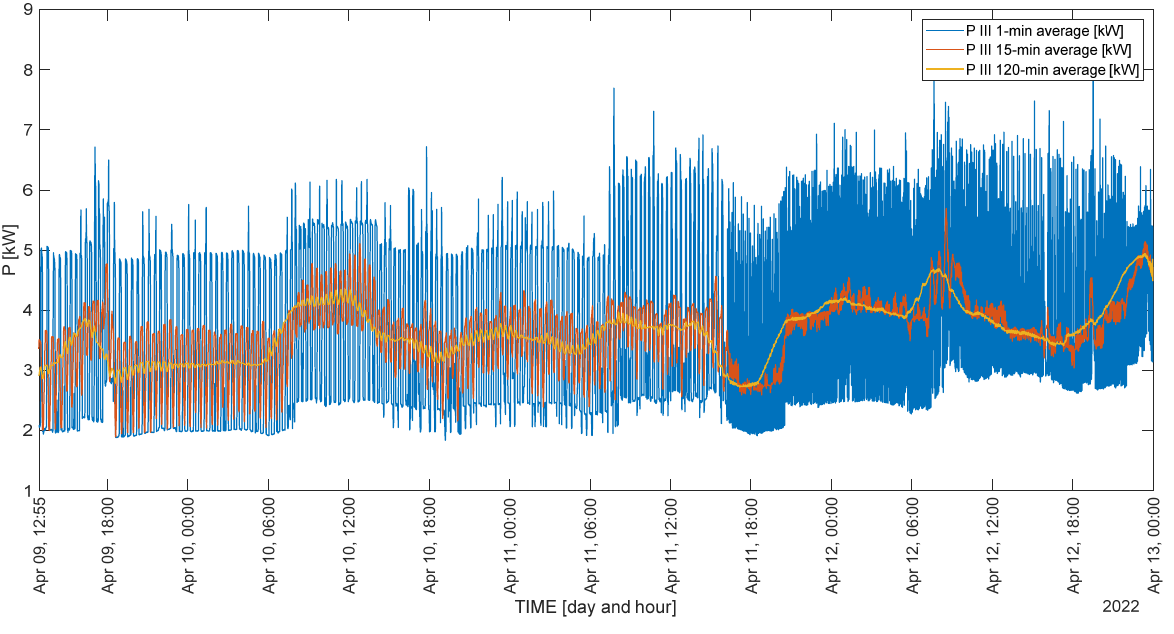
Figure 3. Three-phase active power value as a function of time in the 1st stage of the